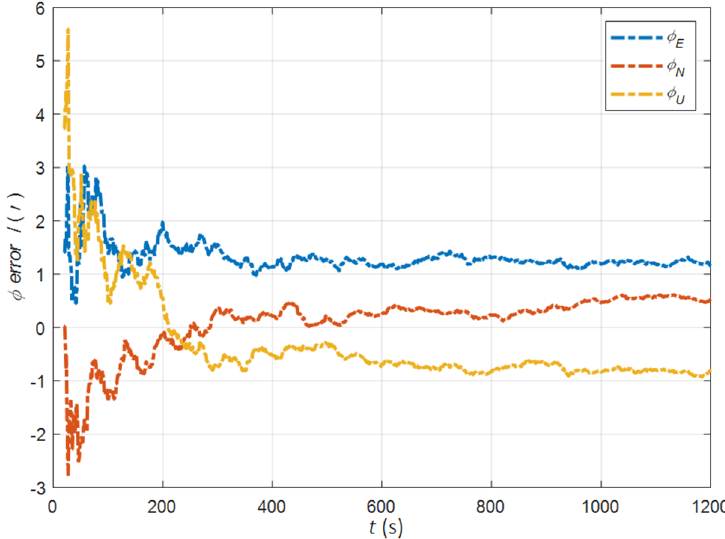
Figure 10. The error curves of